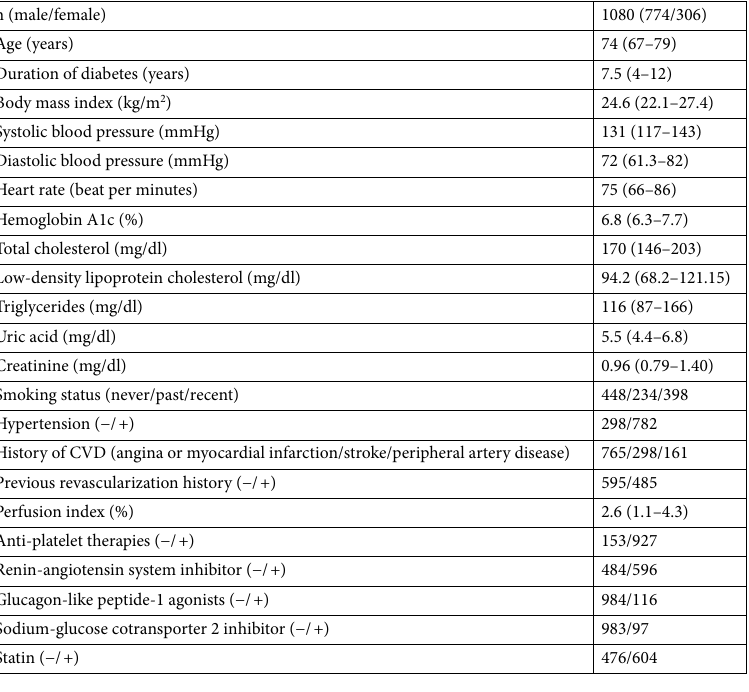
Table 1. Characteristics of patients. Data are expressed as the median (interquartile range) or absolute number. CVD, cardiovascular